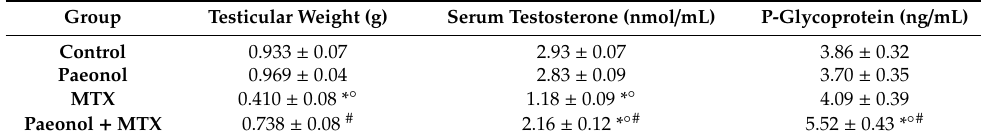
Table 1. E ff ect of paeonol on testicular weight, as well as serum testosterone and testicular P-glycoprotein